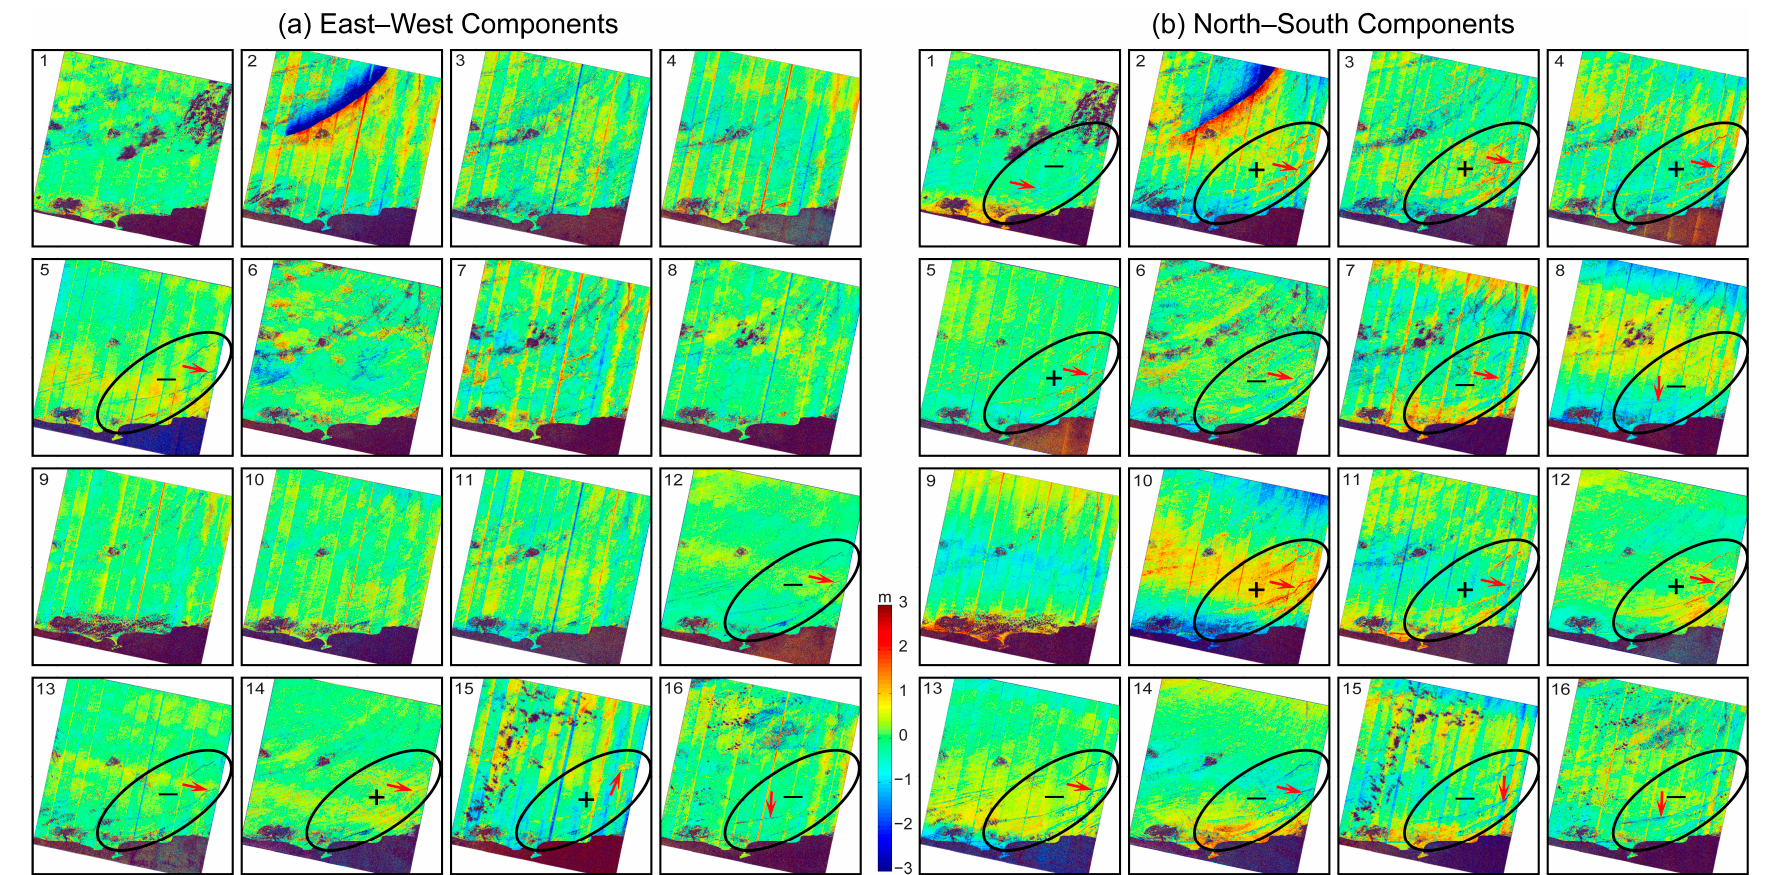
Figure A3. E/W ( a ) and N/S ( b ) deformation fields after removing the orbital error. The black ellipse lines circle the area of dominated TSA in E/W and N/S deformation fields. The symbol (+) indicates eastward and northward offsets of TSA and the symbol ( − ) indicates westward and southward offsets of TSA.